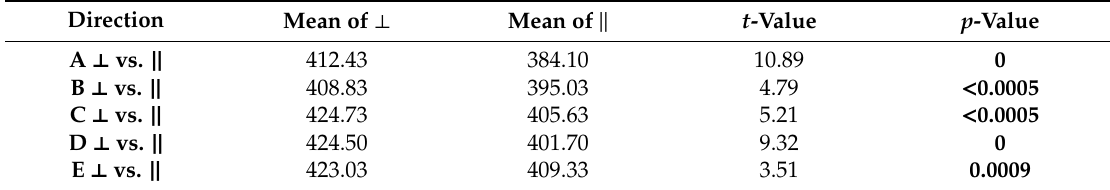
Table 5. Results of the t-test—comparison between two groups.